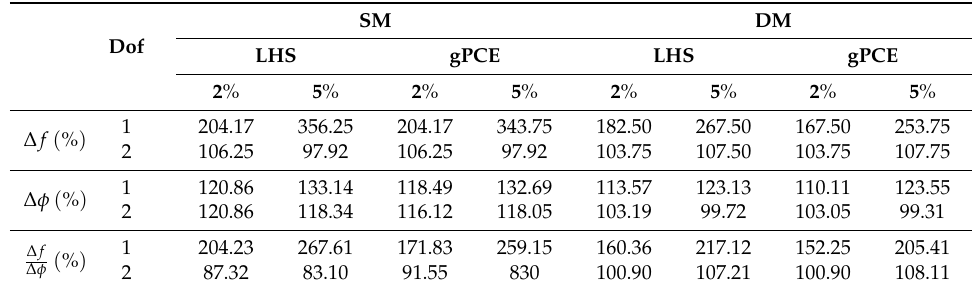
Table 2. Stochastic amplitude and frequency ranges of the multistability domain, according to the SM and DM, with respect to deterministic